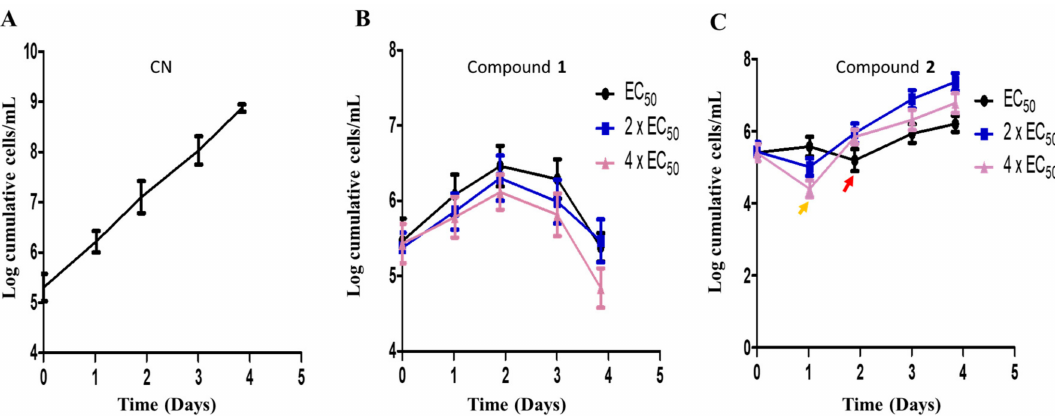
Figure 7. Compound sensitivity analysis in T. brucei. The growth kinetics of T. brucei was investigated in the presence of compounds 1 ( B ) and 2 ( C ) for 96 h at EC 50 , 2 × EC 50 and 4 × EC 50 . Red arrow = growth profile at EC 50 after 48 h ( C ); orange arrow = growth profile at 2 × EC 50 and 4 × EC 50 after 24 h ( C ); CN = negative control ( A